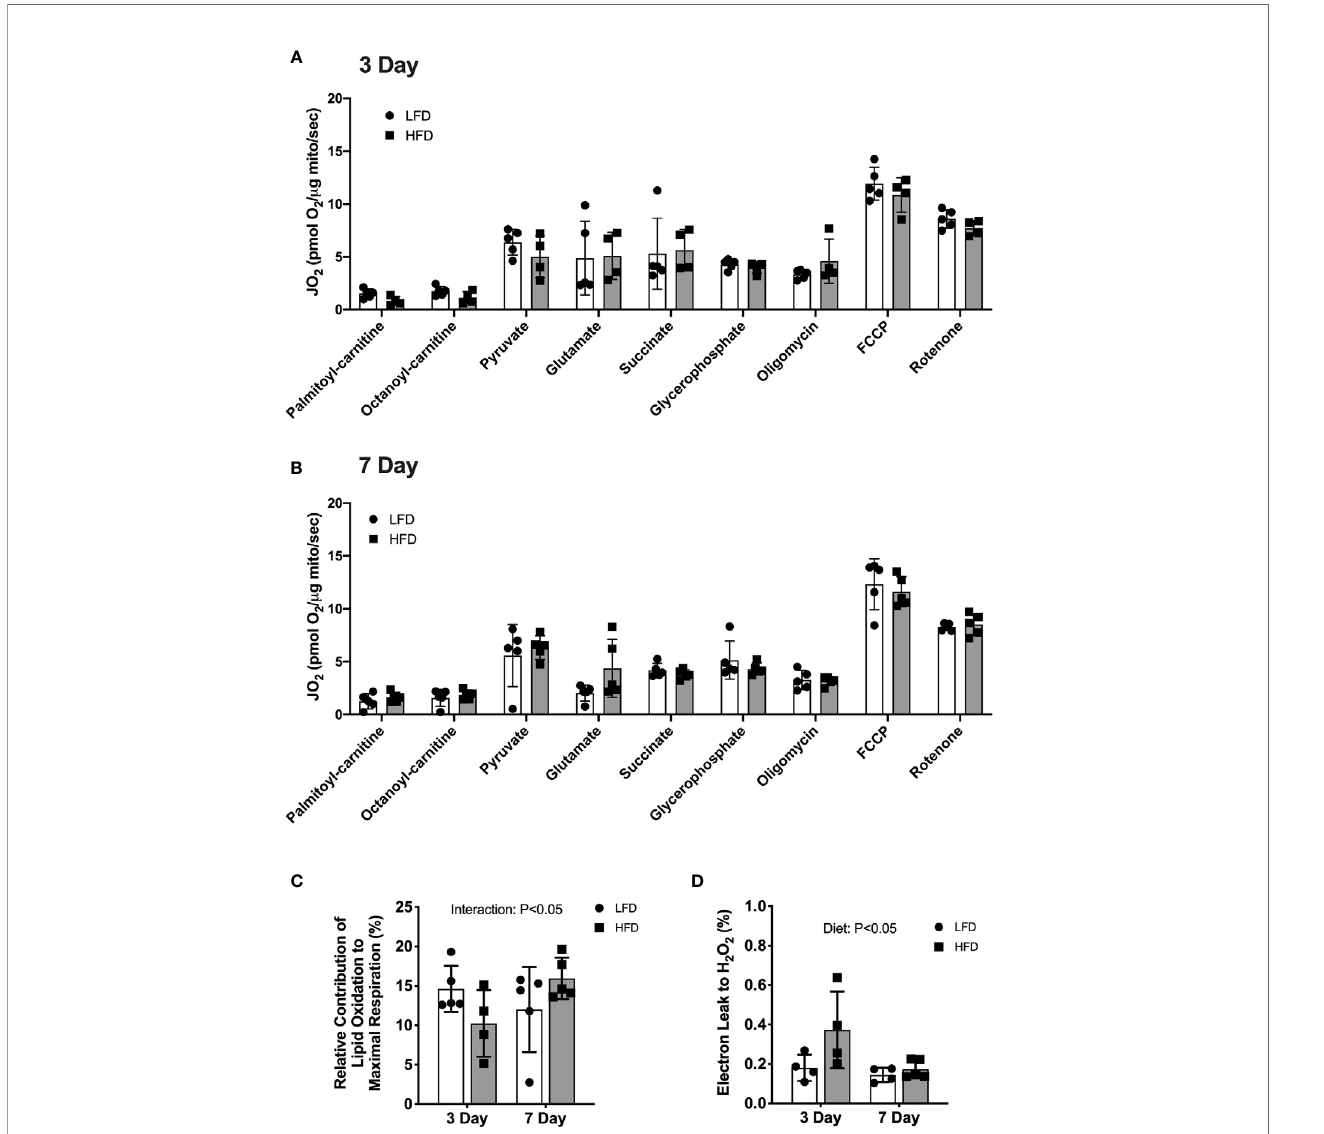
FIGURE 1 | 3 days of high-fat feeding lowered lipid substrate contribution to respiration and stimulated reactive oxygen species production. Mitochondrial respiration of isolated mitochondria from quadriceps muscle during sequential additions of substrates and inhibitors. (A) Rates of oxygen consumption expressed relative to protein content (pmol O 2 / m g protein/sec) from mice fed low-fat or high-fat diet for 3 days. (B) Rates of oxygen consumption expressed relative to protein content (pmol O 2 / m g protein/sec) from mice fed low-fat or high-fat diet for 7 days. (C) Contribution of lipid-supported oxidation expressed as a percentage of maximal respiration measured after FCCP. (D) Electron leak to H 2 O 2 calculated from H 2 O 2 emission during lipid-supported oxidative phosphorylation and expressed as a percentage of oxygen consumption. Data are means ± SD; n=4-5. Repeated measures ANOVA with Tukey ’ s post-hoc tests were used to analyze data in (A, B) . Two-way ANOVA was used to test for effects of diet and time in (C, D) . P values are main